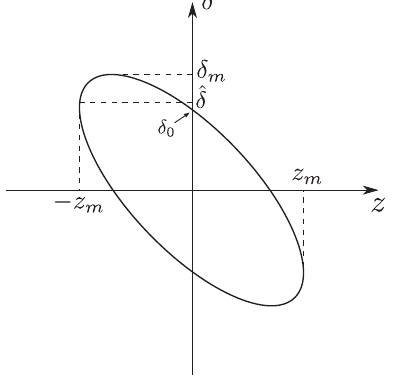
FIG. 1. Definition of parameters in longitudinal phase space. z denotes the longitudinal direction, and δ ¼ Δ p=p 0 is the relative momentum